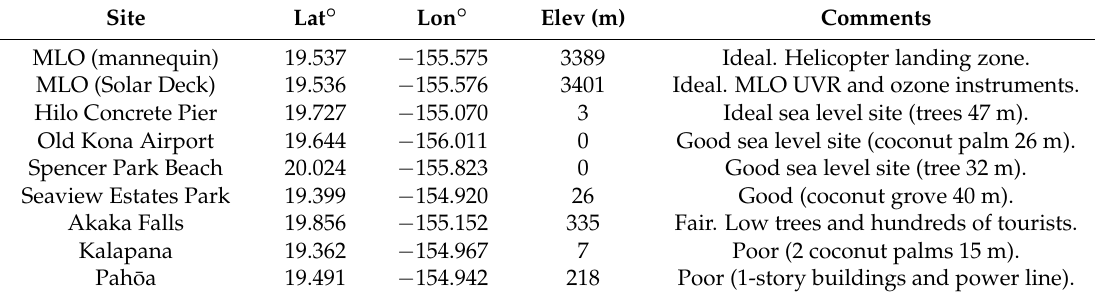
Table 1. Principal UV Index (UVI) measuring sites for Hawai’i Island UVR study in order of their suitability. Site Lat ◦